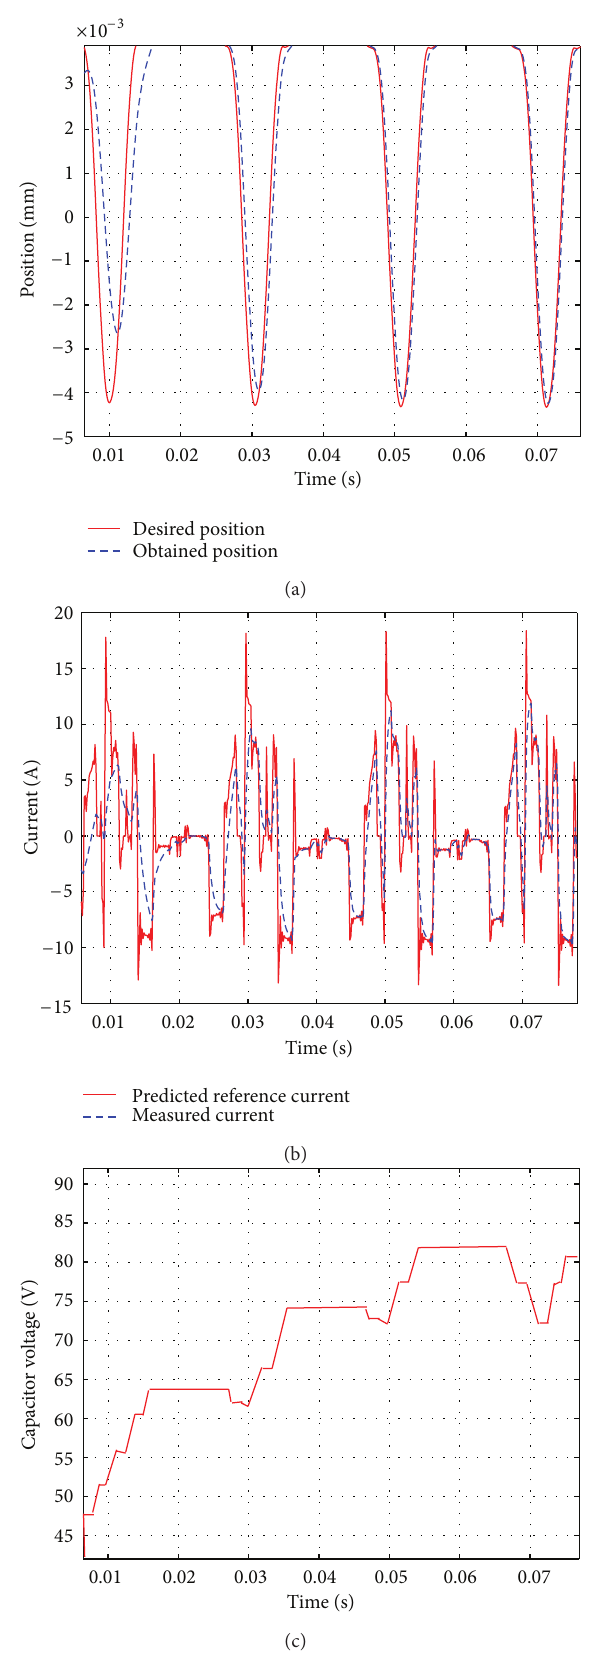
Figure 18: From the top: three cycles for position, current tracking, and capacity charging using